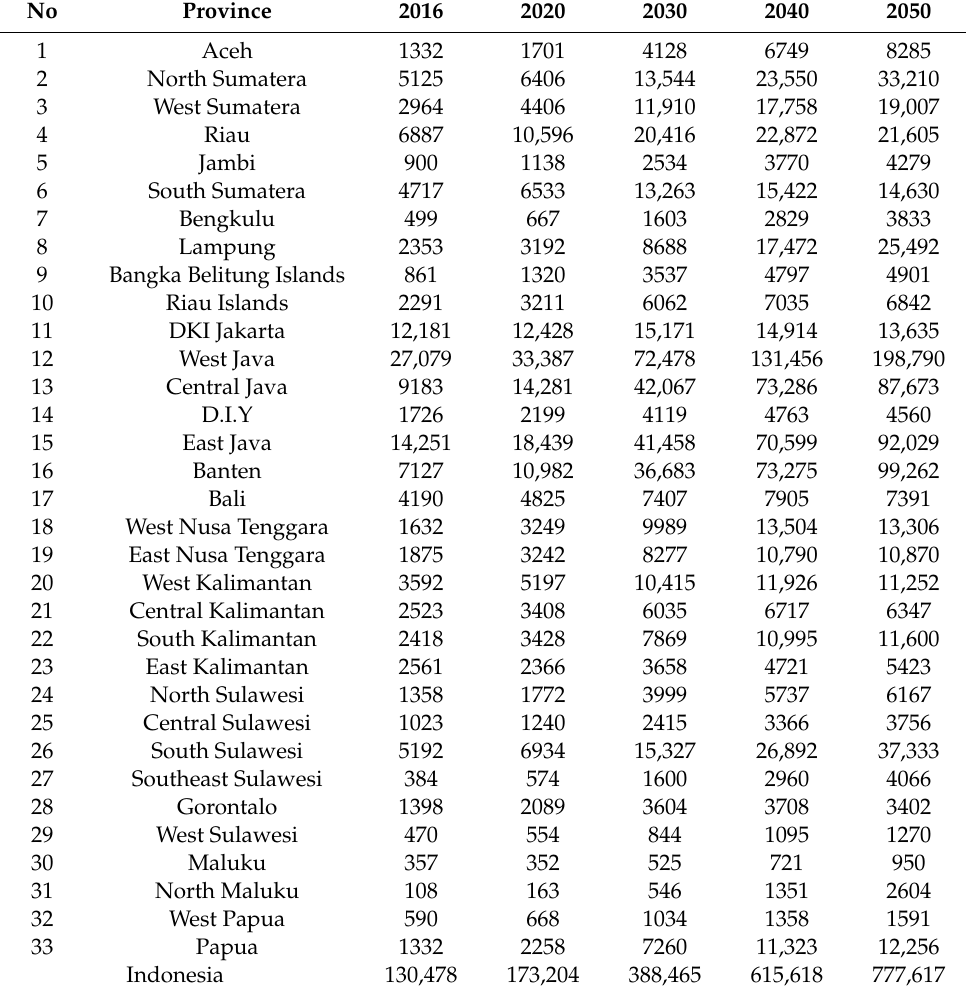
Table 9. VKM projection results for provinces, BAU scenario, 2016–2050 (million VKM ).